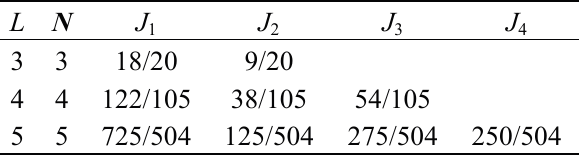
Table 3. FTShc algorithm